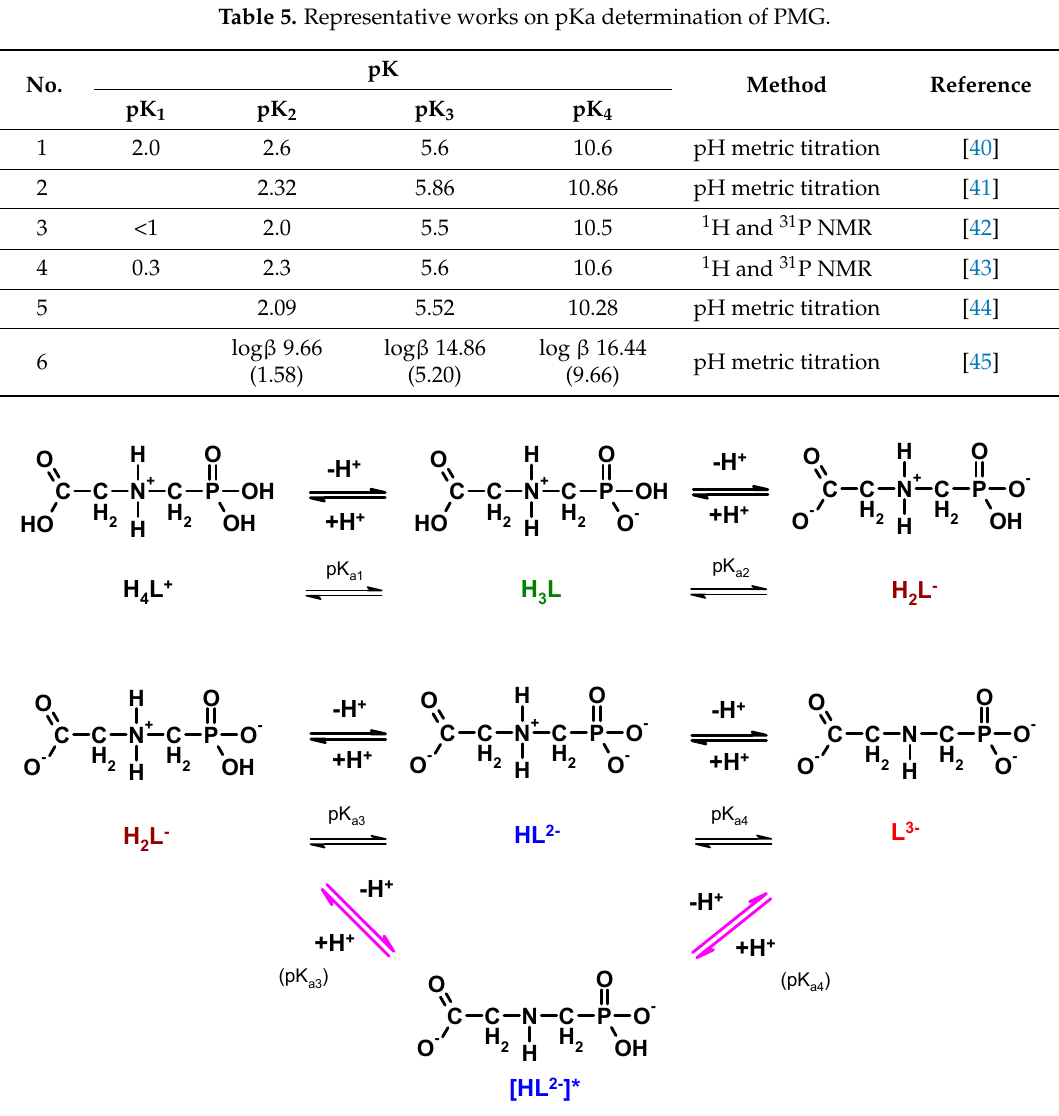
Figure 3. Dissociation/protonation equilibria of glyphosate (lower branch (arrows in magenta)